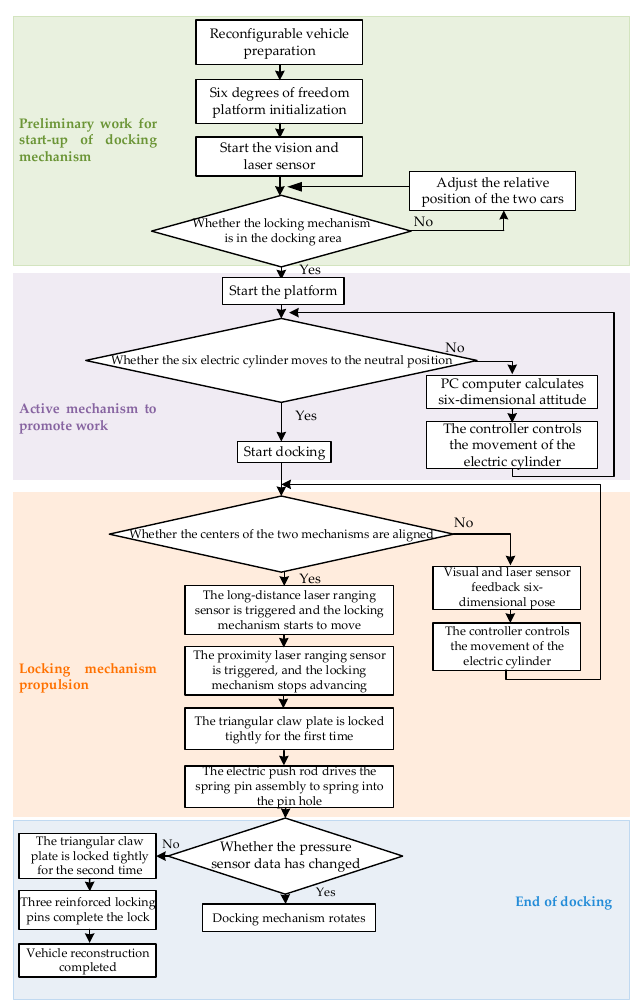
Figure 4. Flow chart of docking process. 3. Control Algorithm of Docking Mechanism Based on Image and Laser Sensor Fu- sion